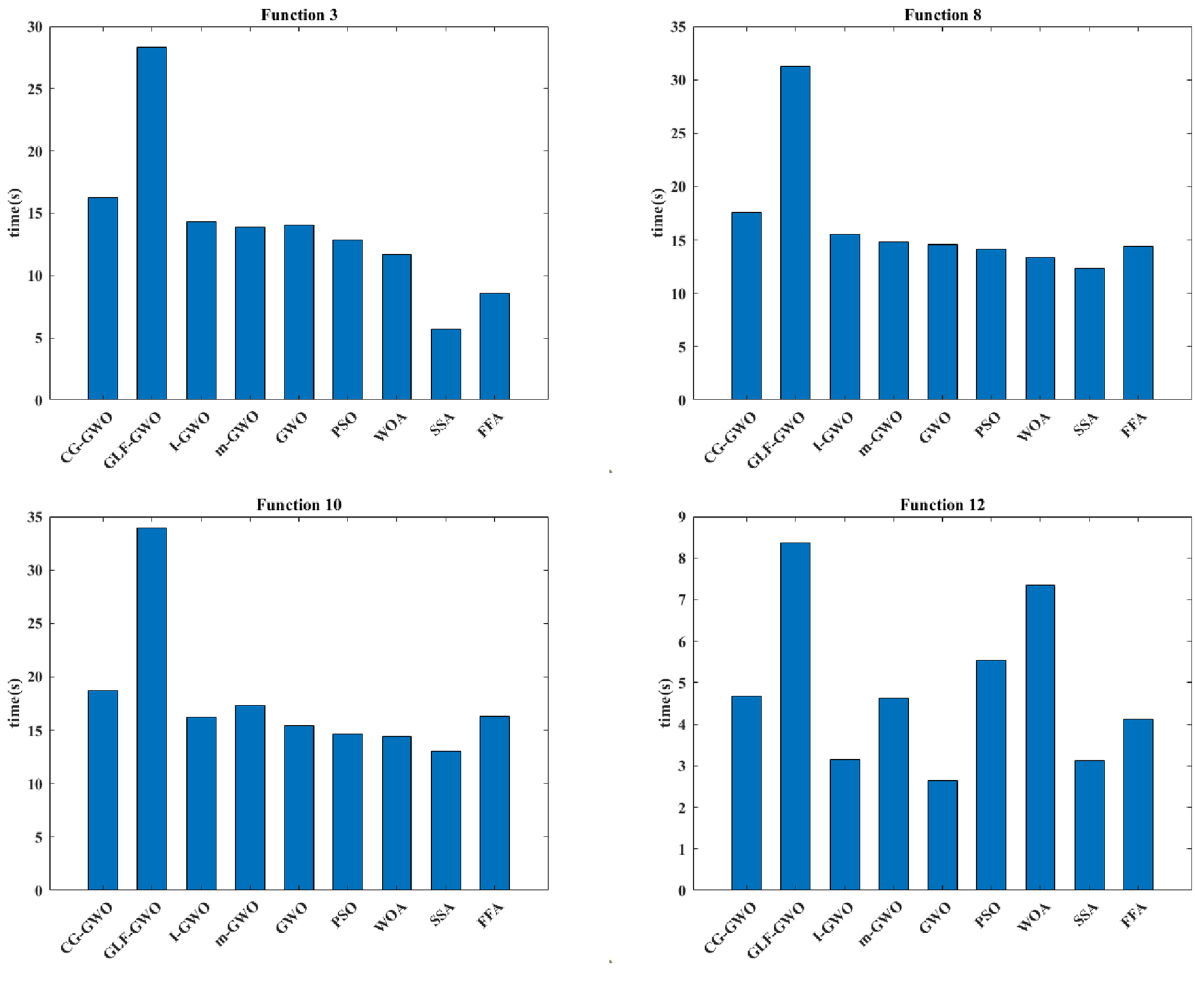
Figure 9. Runtime comparison of algorithms.